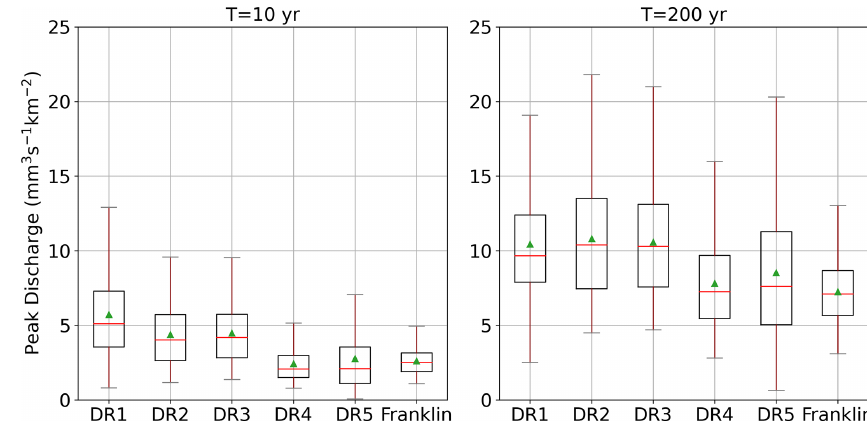
Figure 6. Box plots of normalized flood peaks for Franklintown and five subwatersheds.